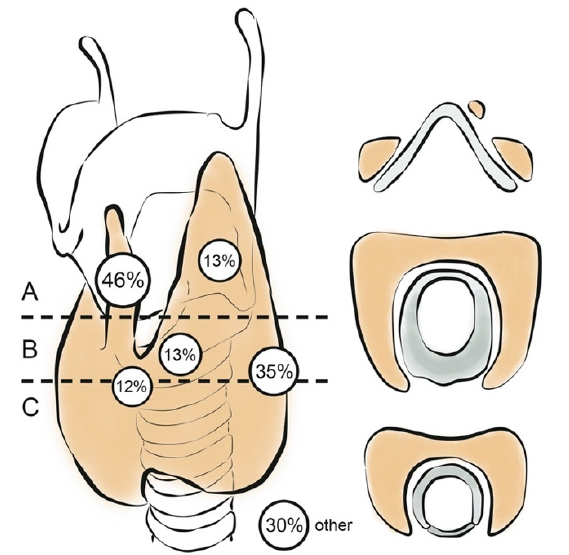
Figure 1. Thyroid remnant anatomical sites. Frequency of thyroid remnants at various anatomical sites within the thyroid bed. Forty-five (46%) remnants were found at the former pyramidal lobe, 34 (35%) at the tracheoesophageal groove, 13 (13%) at the former superior poles, 13 (13%) around Berry’s ligament, 12 (12%) at the former isthmus, and 29 (30%) in other locations, including the thymus and thyroglossal duct.